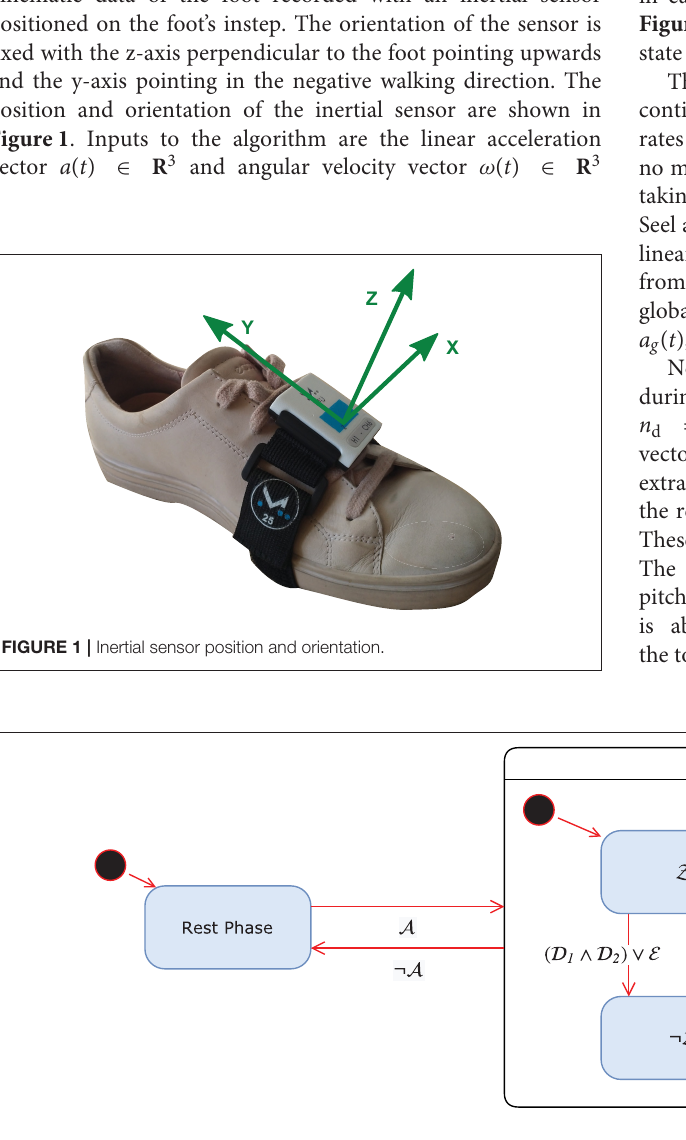
FIGURE 2 | GPD state